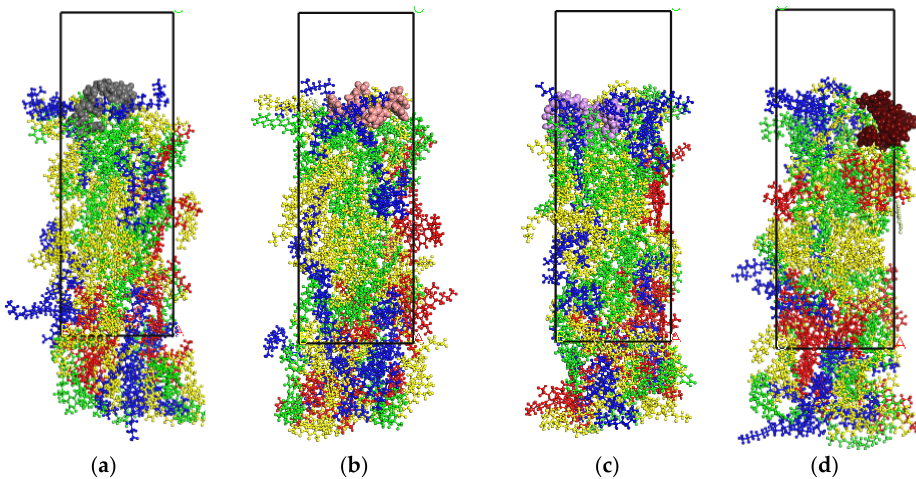
Figure 8. After molecular dynamics simulation of the asphalt–SBS interaction layer. ( a ) 2/8. ( b ) 3/7. ( c ) 4/6. ( d ) 5/5.